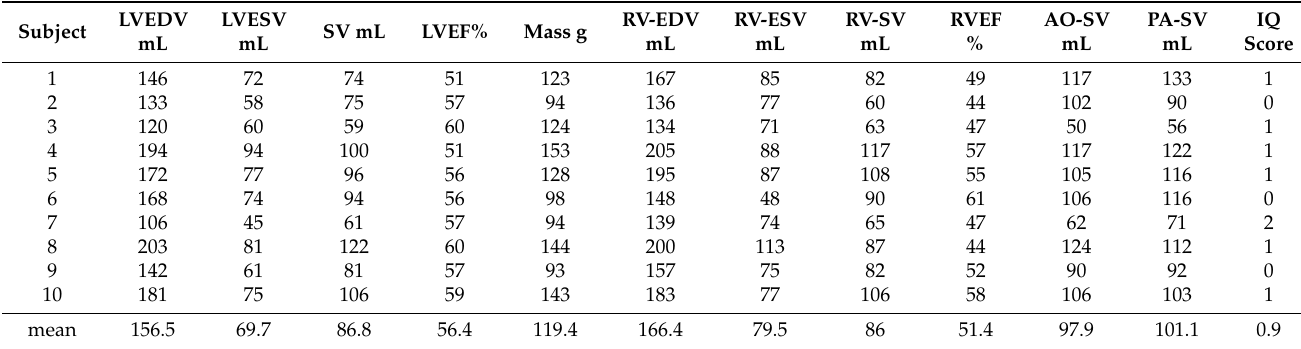
Table 1. Quantitative volumetric analysis of 7T cardiovascular magnetic resonance (CMR) data sets for left and right ventricular volumes, and aortic and pulmonary